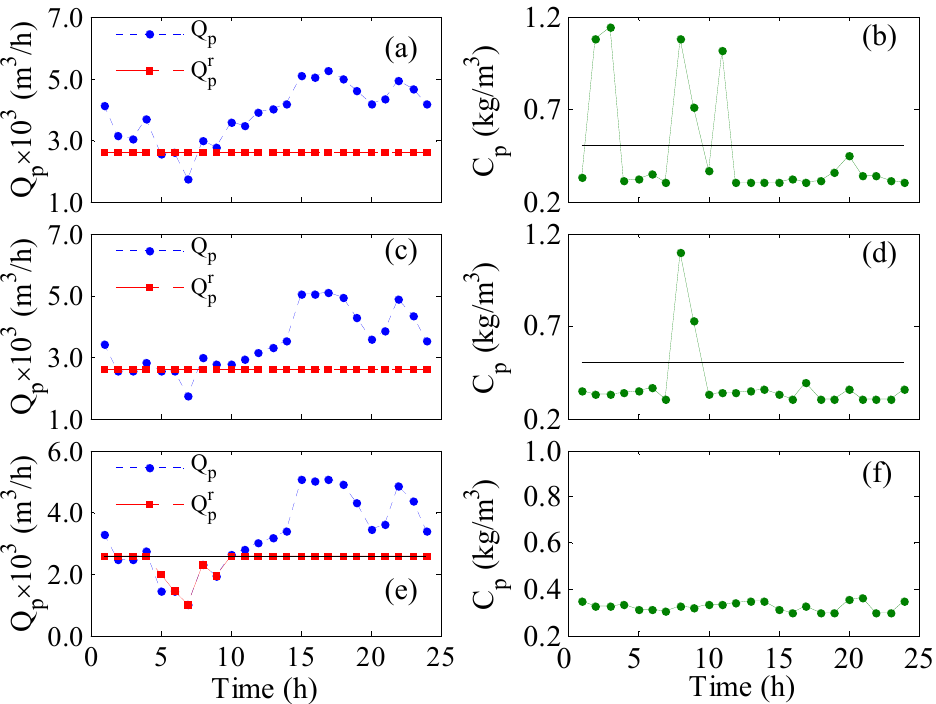
Figure 5. Instantaneous control results in the presence of disturbances ( a , b ): Bounded LP ; ( c , d ): unbounded using LPb objective; ( e , f ) fixed.